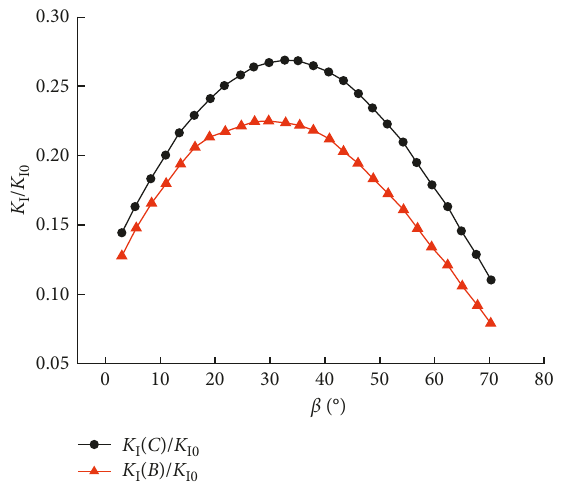
Figure 8: Relation of the normalized SIF and preexisting crack inclination angle ( a 1